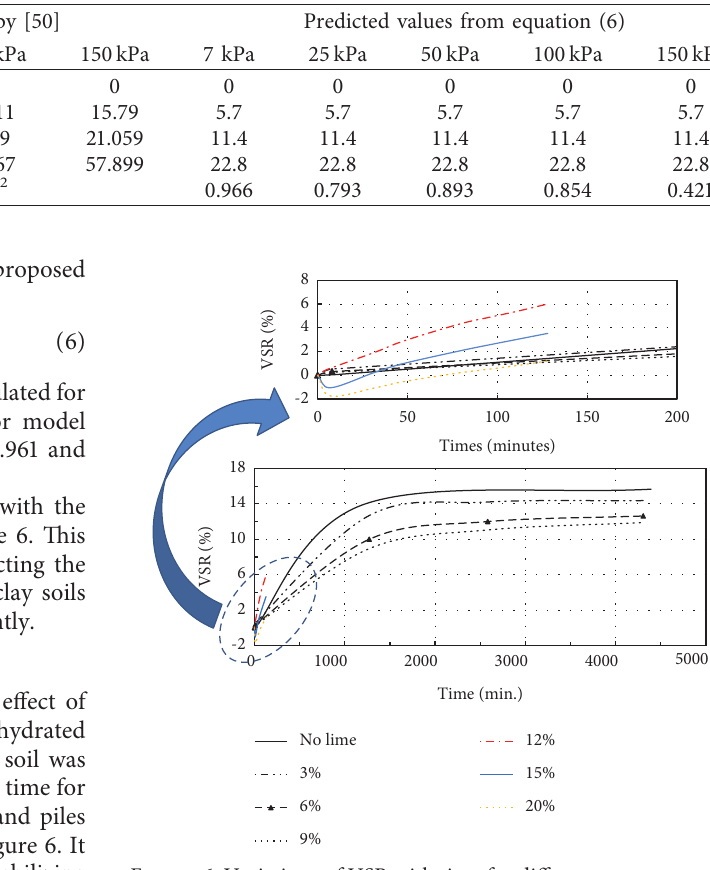
Figure 6: Variations of VSR with time for different percentages of lime content in the sand pile (RAR �